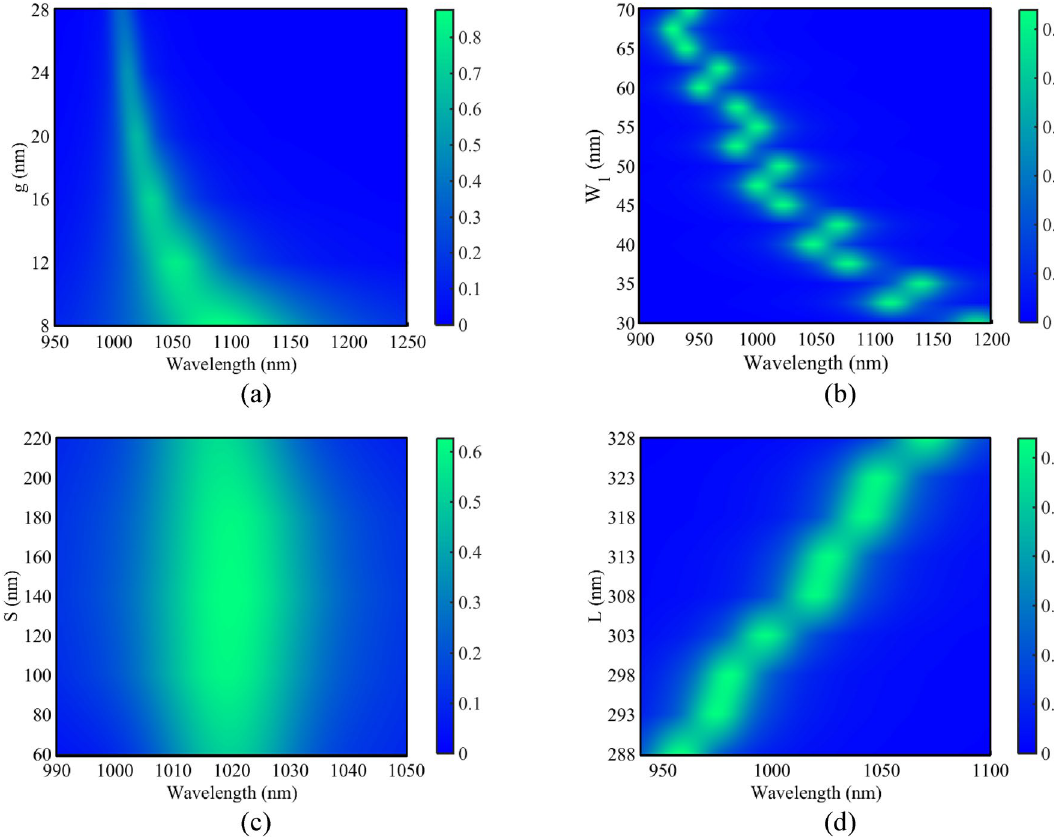
Figure 3. Transmission spectra of Fig. 1a for different values of (a) g, (b) W 1 , (c) S, (d) L.